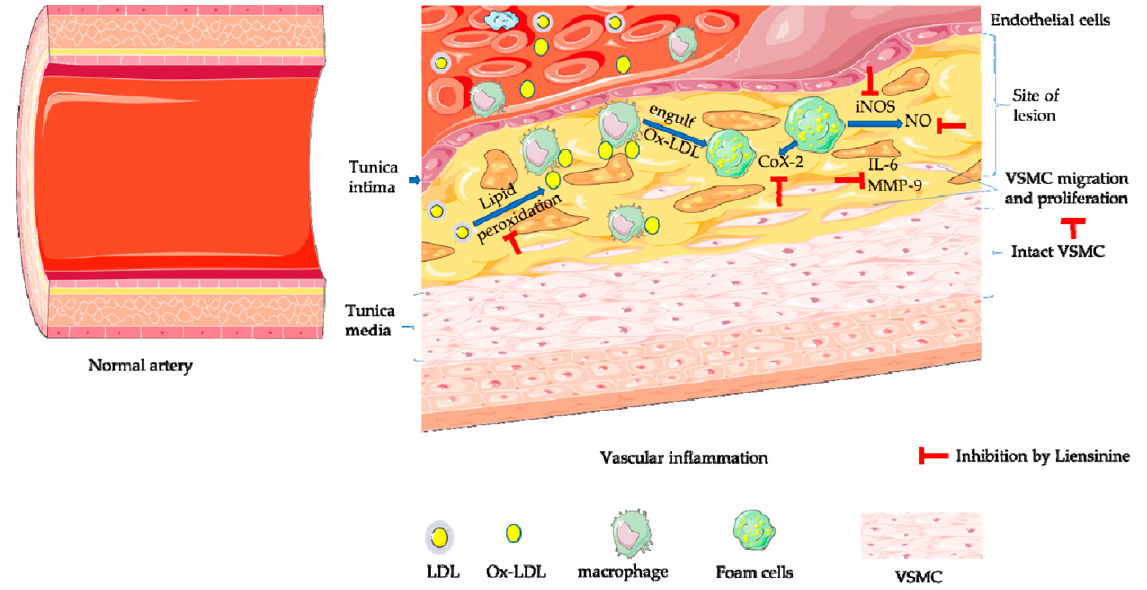
Figure 7. The mechanism of action of liensinine to inhibit vascular inflammation: During the progression of vascular inflammation, low density lipoprotein (LDL) is oxidized to ox-LDL by free radicals and these ox-LDL are engulfed/phagocytized by macrophages. The macrophage converts its phenotype to activated foam cells distinguished by the accumulation of fatty streaks of ox-LDL. These activated macrophages release numbers of inflammation mediators such as nitric oxide (NO), TNF- α , inducible nitric oxide synthase (iNOS) and cyclooxygenase (COX-2). Similarly, the intact vascular smooth cells (VSMC) in the tunica media are activated by cytokines such as TNF- α and growth factor such as PDGF. VSMCs release cytokines such as IL-6 and initiate proliferation mediated by PDGF and migration mediated by matrix metalloproteinase-9 (MMP-9) enzymatic activity at the site of a lesion. Collectively, this process leads to vascular inflammation flowed by atherosclerosis.